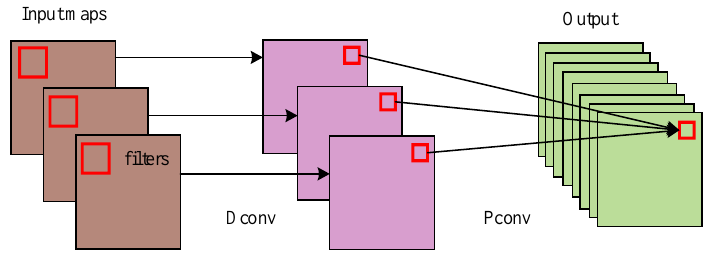
Figure 3. Depths-wise separable convolution.